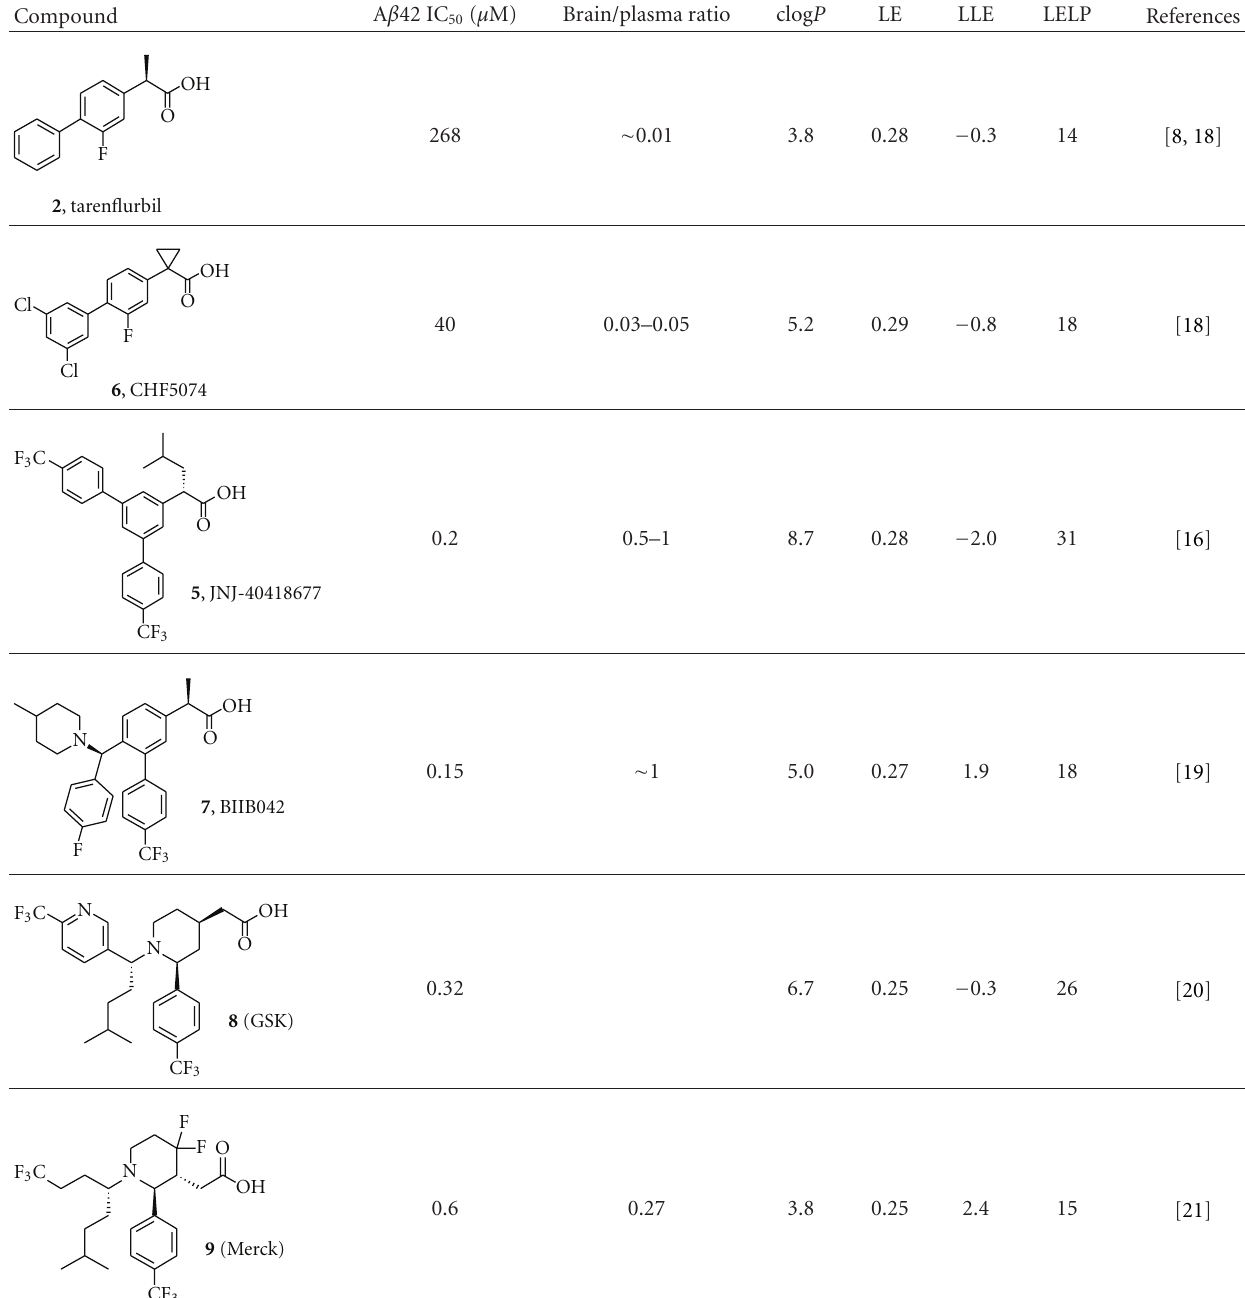
Table 1: Key parameters and e ffi ciency indices of a set of representative acid GSMs.